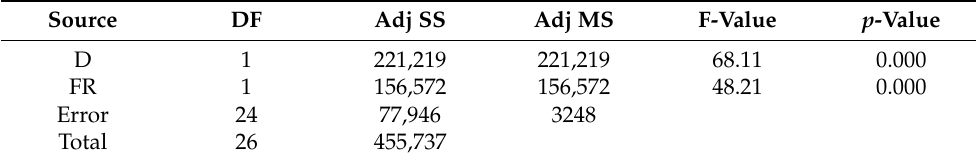
Table 5. ANOVA results for F using conventional cutting edge.